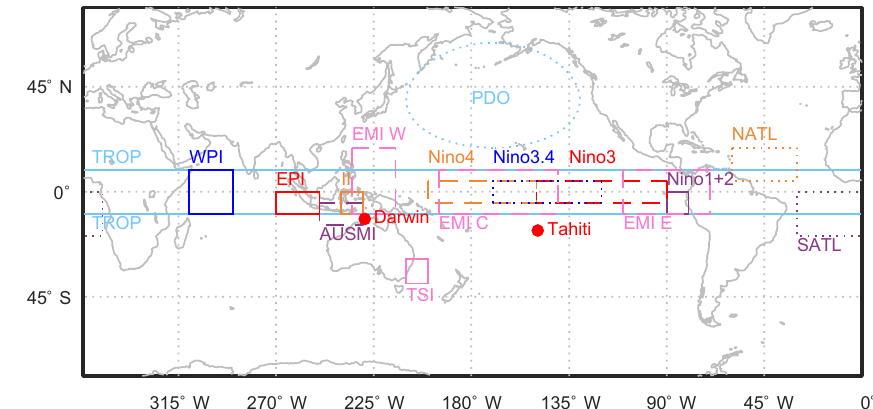
Figure 2. Approximate climate index measurement regions. Climate indices are calculated over the following areas: WPI – solid blue rectangle, EPI – solid red rectangle, DMI – the difference between the WPI and the EPI, SOI – calculated using MSLP measurements at Tahiti and Darwin (red dots), TSI – solid pink rectangle, Niño 1+2 – solid purple rectangle, Niño 3 – dashed red rectangle, Niño 3.4 – dotted blue rectangle, Niño 4 – dashed orange rectangle, NATL – dotted orange rectangle, SATL – dotted purple rectangle, TROP – calculated between top and bottom light blue lines, EMI – calculated using areas enclosed by dashed pink rectangles, II – solid orange rectangle, AUSMI – dashed purple rectangle and PDO – dashed light blue oval (note: PDO is calculated over the entire area of the Pacific Ocean north of 20°N, the oval is only included for illustrative purposes). Figure produced using definitions for climate indices listed in Section 2.2.